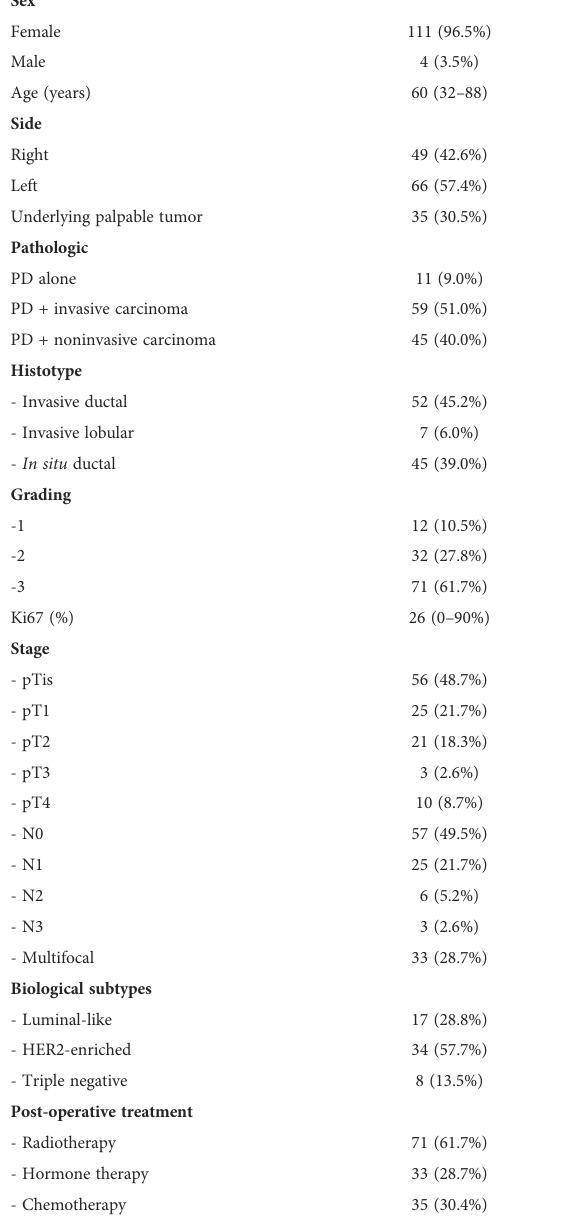
TABLE 1 Characteristics and clinicopathological features of 115 patients with con fi rmed Paget ’ s disease.